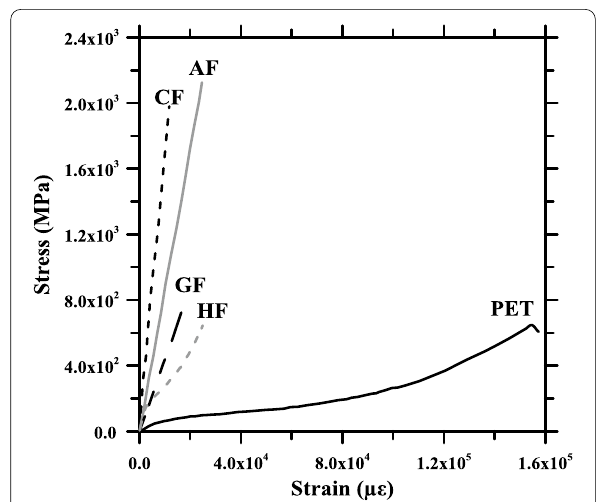
Fig. 1 Stress–strain relationship of fibers used in